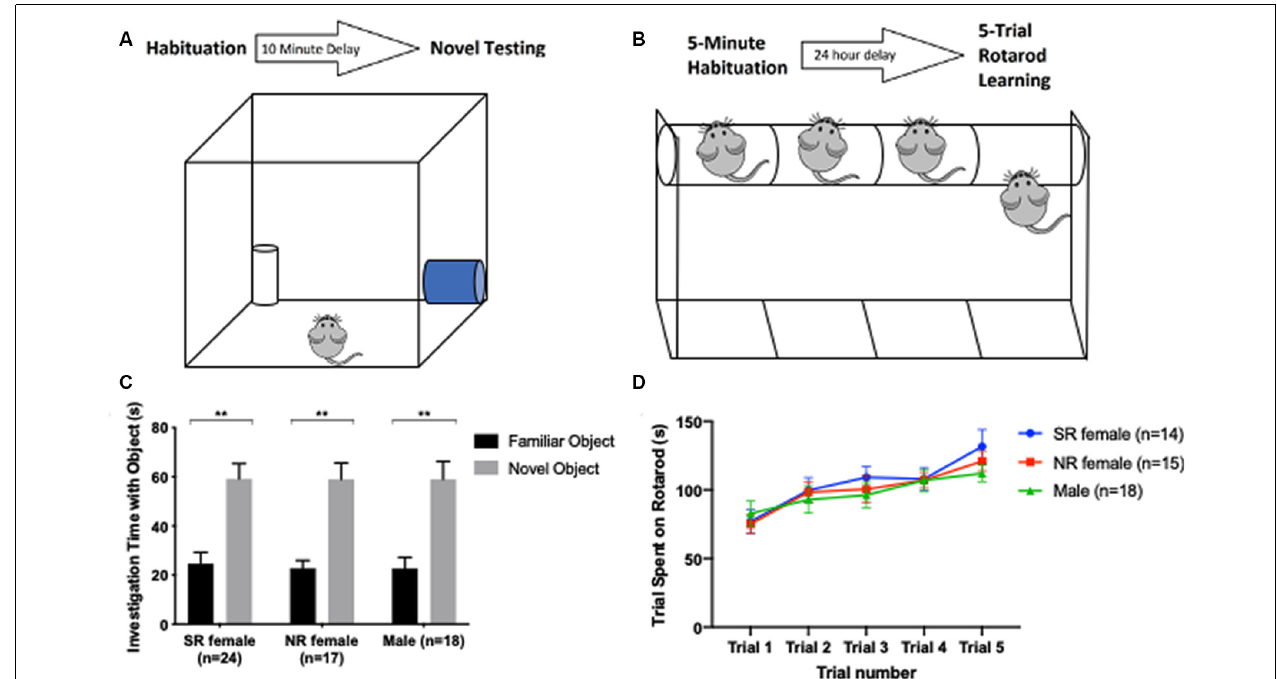
FIGURE 3 | Short-term memory and motor learning are not influenced by the estrus cycle. Timeline and apparatus for the novel object. Mouse initially habituates to two identical objects (trial ends after a total of 20 s spent interacting with both objects). After 10 min, the mouse is placed back into the novel object arena for 5 min with a novel object and one of the two objects it habituated to (A) . Timeline and apparatus for rotarod motor learning task. Mouse initially habituates walking on a rotarod beam for 5 min. After 24 h, the mouse undergoes five consecutive trials, and time spent on the platform before falling off is recorded per trial (B) . Both female groups and males showed a significant preference for a novel object over a familiar object (C) . In the rotarod task, all groups spent more time on the rotarod from one trial to the next, as expected for C57 mice, and did not show significant difference among one another for time spent on the rotarod in each trial (D) . ** <